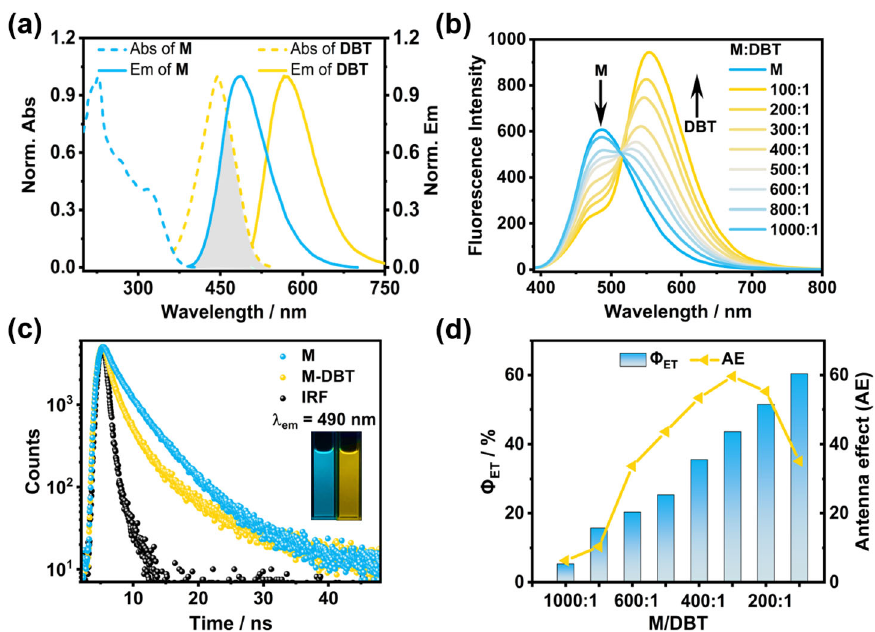
Figure 3. ( a ) Normalized absorption spectra of M and DBT (dashed lines) and their normalized fluorescence spectra (solid lines). ( b ) Fluorescence spectra of M dimer NPs with different concentrations of DBT . ( c ) Fluorescence decay profiles of NPs of M and M ‐ DBT , λ ex = 330 nm; inset: photographs of M and M ‐ DBT under UV light. [ M ] = 5 × 10 − 5 M, [ DBT ] = 5 × 10 − 7 M. ( d ) Φ ET and AE at different M/DBT ratios.